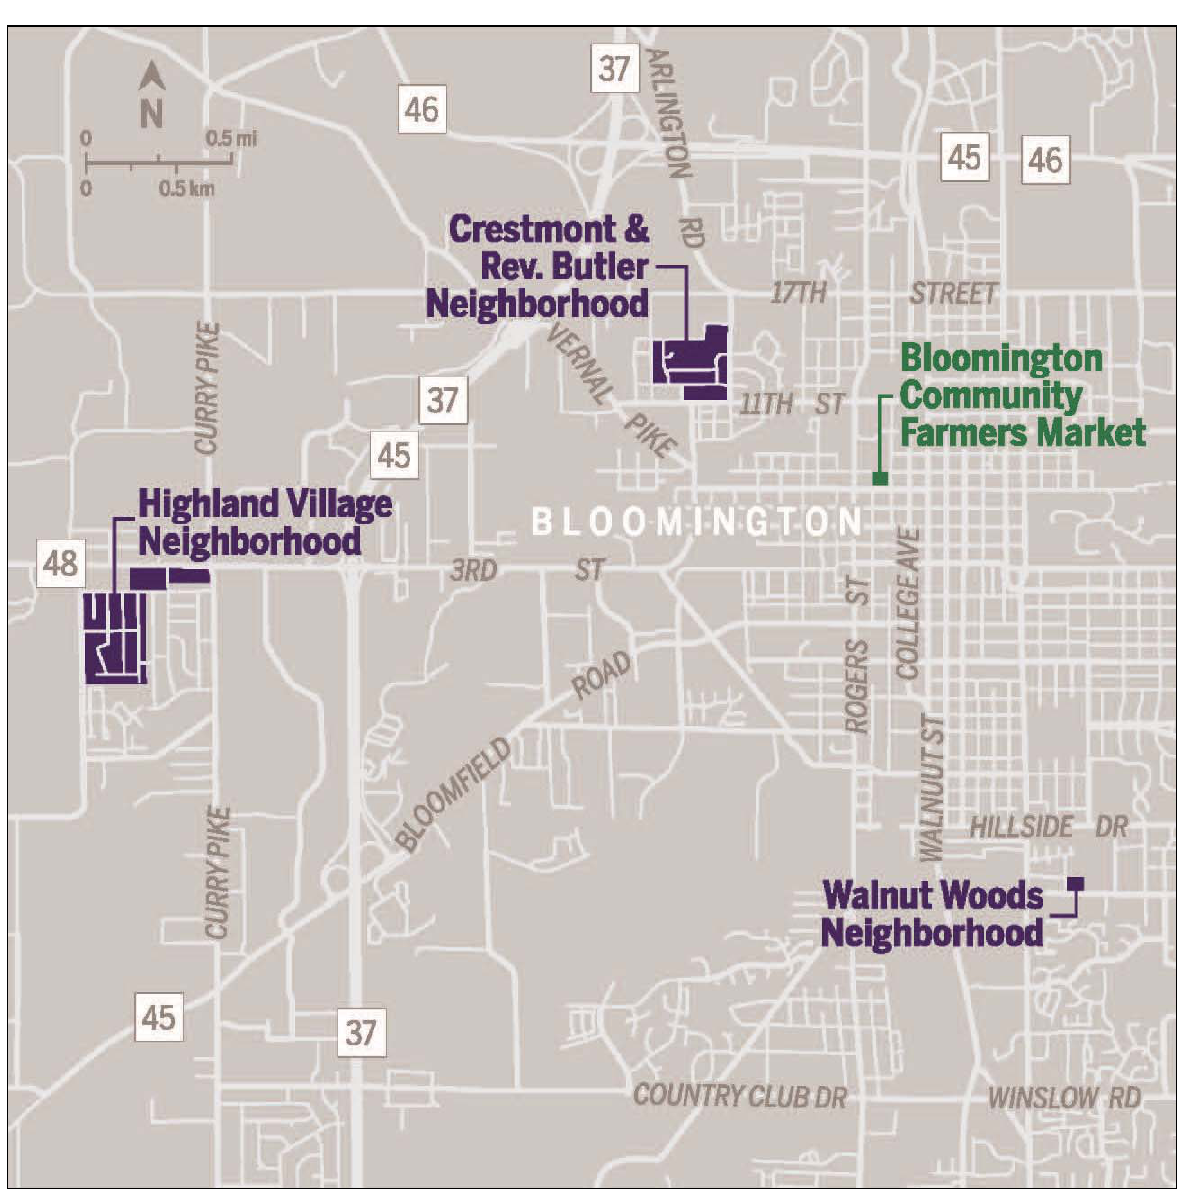
Figure 1. Map of Bloomington, Indiana, Research Sites and Location of Bloomington Community Farmers’